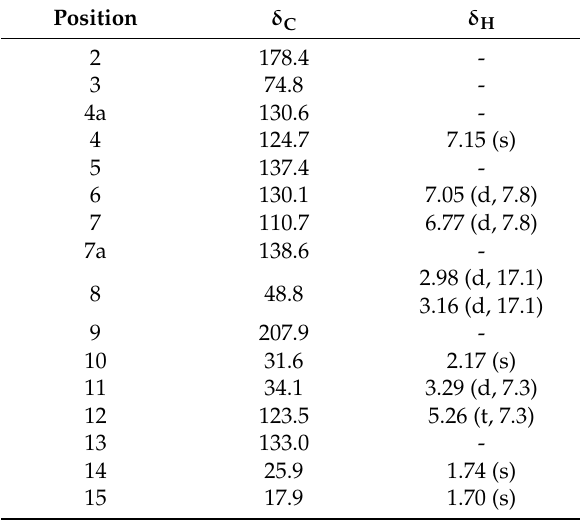
Table 2. NMR spectroscopic data of 2 in CDCl 3 .